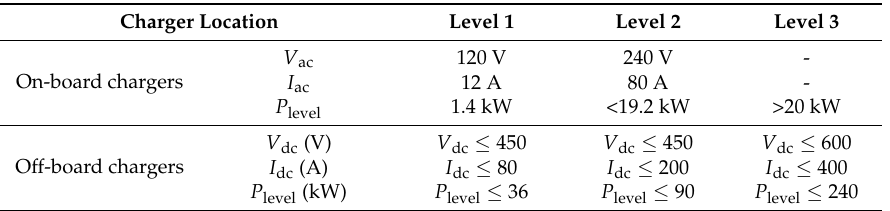
Table 1. Converter specifications and requirements.